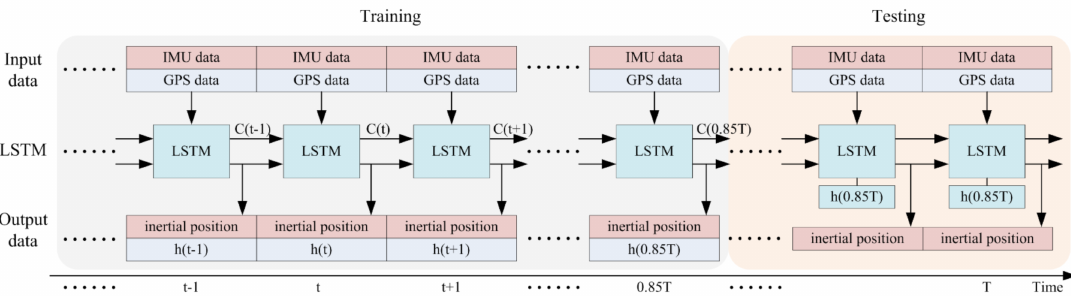
Figure 2. Training and testing the LSTM to estimate position